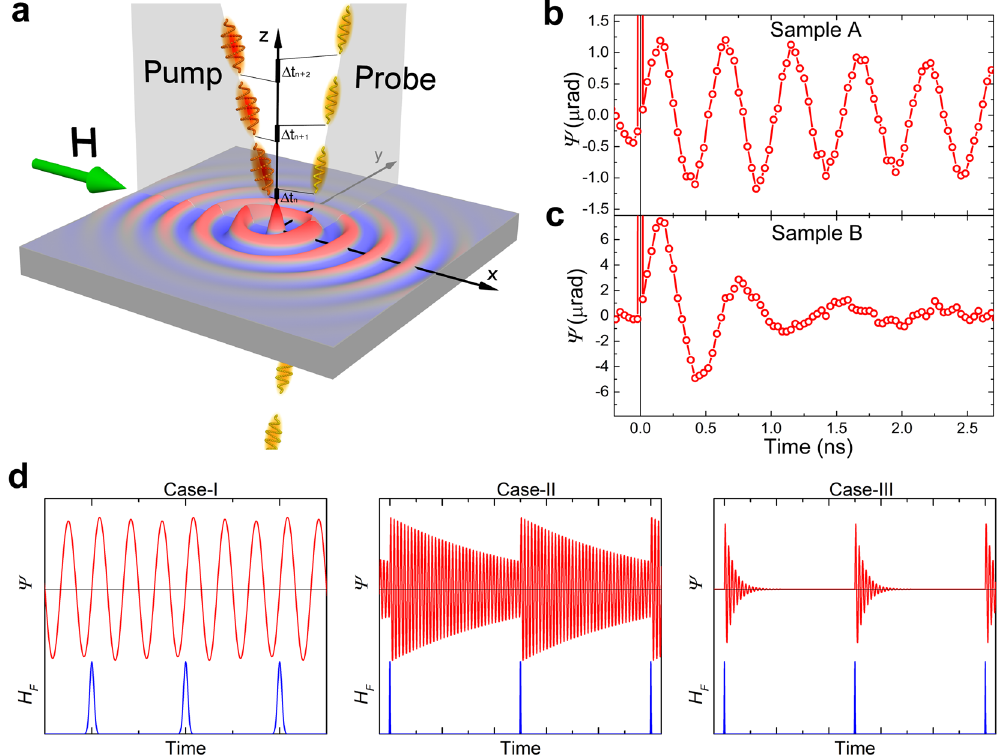
Figure 1. Excitation of the magnetization dynamics by the periodic pulses. (a ) Scheme of the pump-probe experiment. The sample is illuminated with pairs of pump and probe pulses. The time delay between the pump and probe pulses varies Δ t n from 0 to 2.6 ns. ( b , c) Oscillations of the Faraday rotation of the probe beam polarization, demonstrating magnetization precession in the sample-A ( b ) and B ( c ) excited by the 80MHz- laser. The external magnetic field is 590 Oe. ( d) Three considered cases of the ratio of the interval between pump pulses ( T ) and decay time of the magnetization precession ( τ ): (case-III). Red curve represents the magnetization precession and the blue one represents effective magnetic field of the inverse Faraday